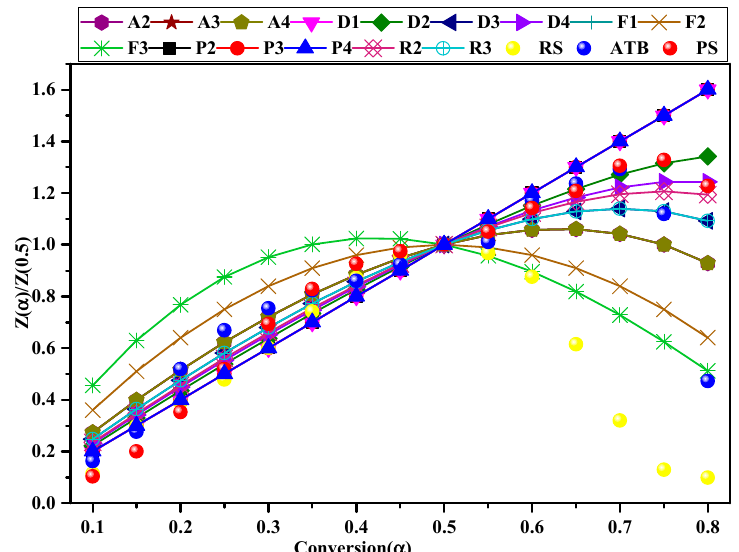
Figure 5. Master plot for theoretical models and experimental data variation with the conversion for RS, ATB, and PS.